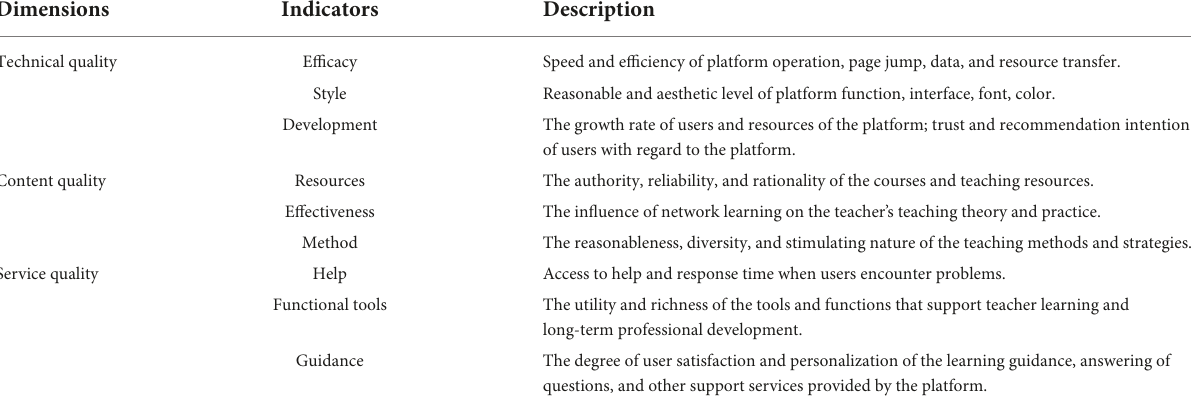
TABLE 2 The dimensions and indicators of